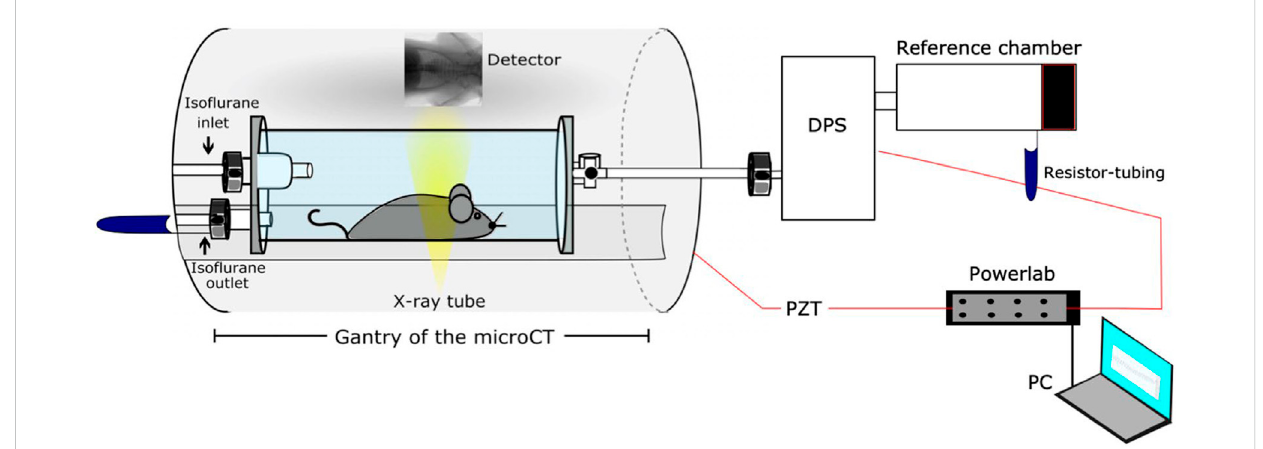
FIGURE 6 Schematic of the developed setup by Khan et al. for correlative XLF, WBP, and µCT measurements [reprinted from Khan et al. (Khan et al.,